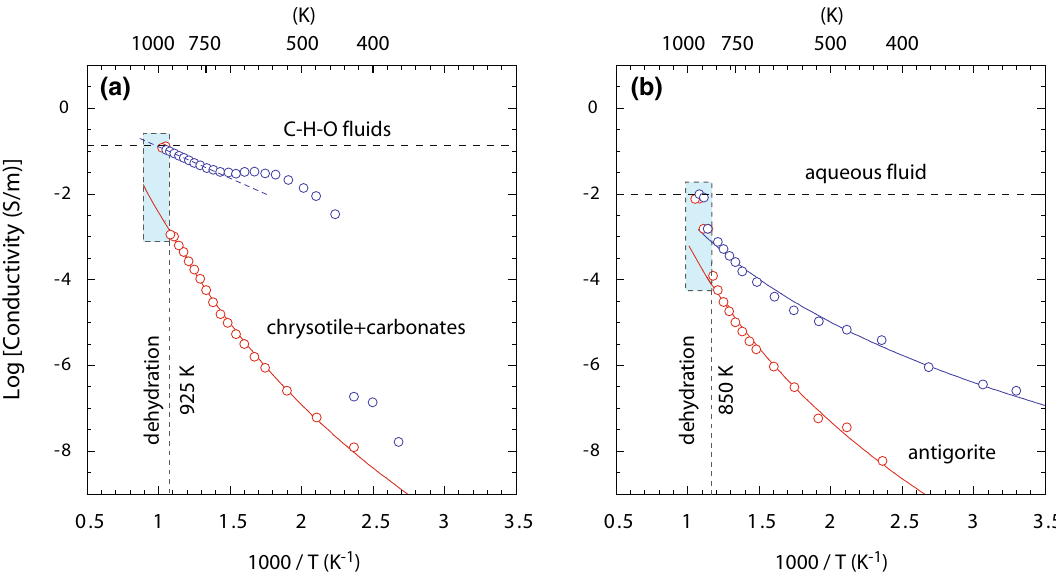
Figure 2. The electrical conductivity of serpentine as a function of reciprocal temperature for ( a ) chrysotile and ( b ) antigorite. The red open circles represent the electrical conductivity of the serpentine samples collected during the heating path (i.e. with increasing temperature). The blue open circles indicate electrical conductivity obtained in the cooling path. The dashed vertical lines indicate the observed devolatilization temperatures determined based on the discontinuous enhancements in the electrical conductivity. The blue shaded area indicates the conductivity increase associated with the devolatilization. The horizontal lines indicate the maximum electrical conductivity observed for released aqueous fluids upon dehydration of the two samples.